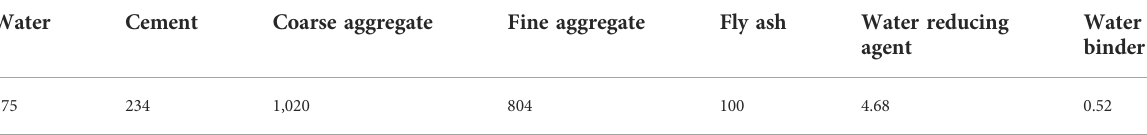
TABLE 3 Mix proportion of commercial ordinary concrete (Unit: kg/m 3